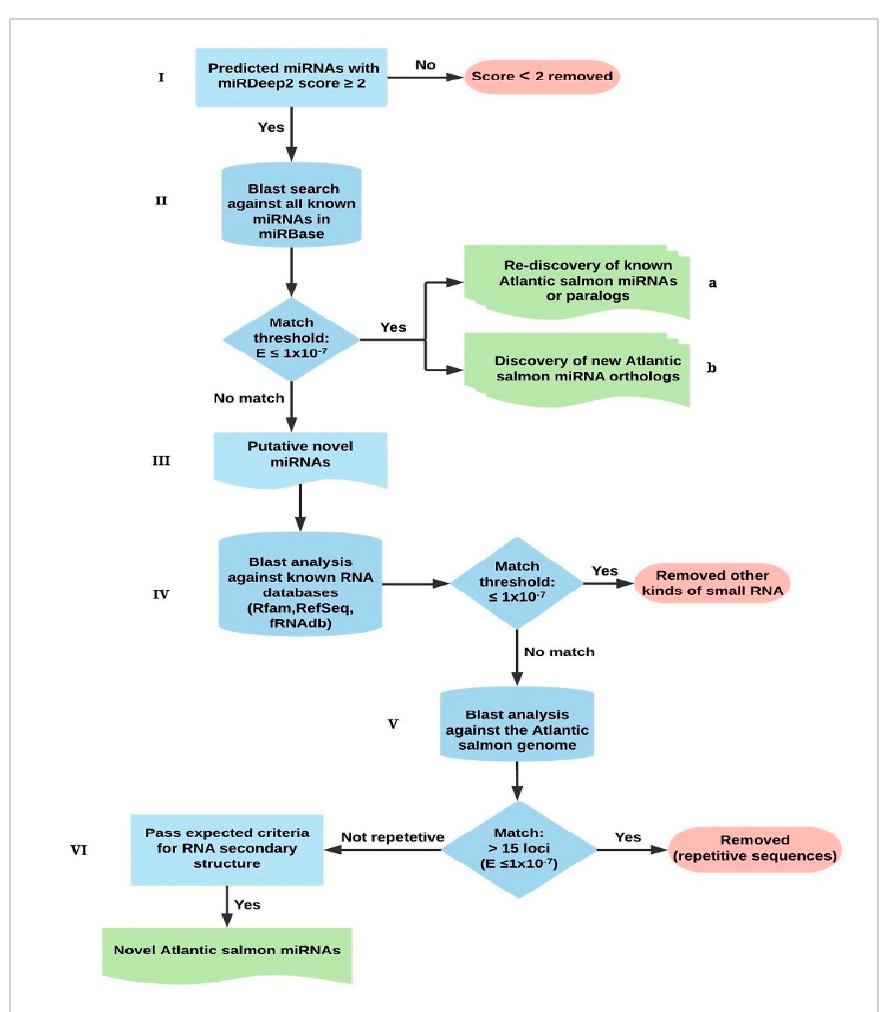
Figure 1. Identification and characterization of Atlantic salmon microRNAs (miRNAs). (I) Candidate miRNAs with miRdeep2 score ≥ 2 were regarded as putative miRNAs. (II) miRNA precursors were used as input for BLAST search against miRBase to identify; ( a ) Atlantic salmon miRNAs already in the database and new paralogs, ( b ) Orthologues of other teleost miRNAs not discovered in prior studies of Atlantic salmon. (III) Candidate miRNAs with no significant matches (e ≤ 1 × 10 − 7 ) to miRBase were considered as putative novel Atlantic salmon miRNAs. (IV) Putative novel miRNA precursor sequences were BLAST analyzed against other RNA databases (Rfam, NCBI RefSeq and fRNAdb) to remove those that were other kinds of small RNA. (V) Sequences with no matches in these databases were further used for BLAST analysis against the Atlantic salmon reference genome sequence. Significant matches (e ≤ 1 × 10 − 7 ) to more than 15 loci in the Atlantic salmon genome were annotated as interspersed repeats and removed. (VI) The remaining putative novel miRNAs were compared against expected features of precursors and their mature miRNAs. The candidates that passed all these criteria were regarded as novel Atlantic salmon miRNAs.